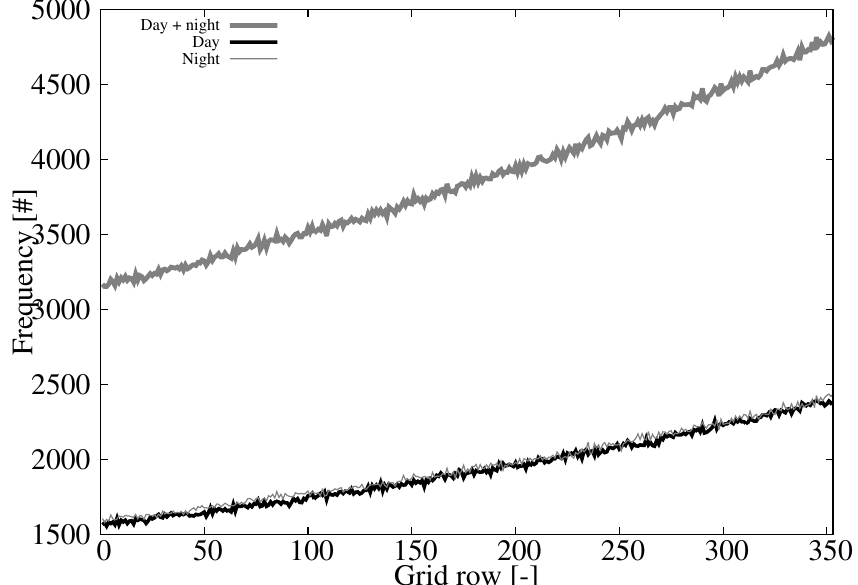
Figure 2. Number of CALIPSO and ACM matching pairs as a function of the grid row for: day and night pairs (thick gray ine), daytime pairs (black line), and nighttime pairs (thin gray